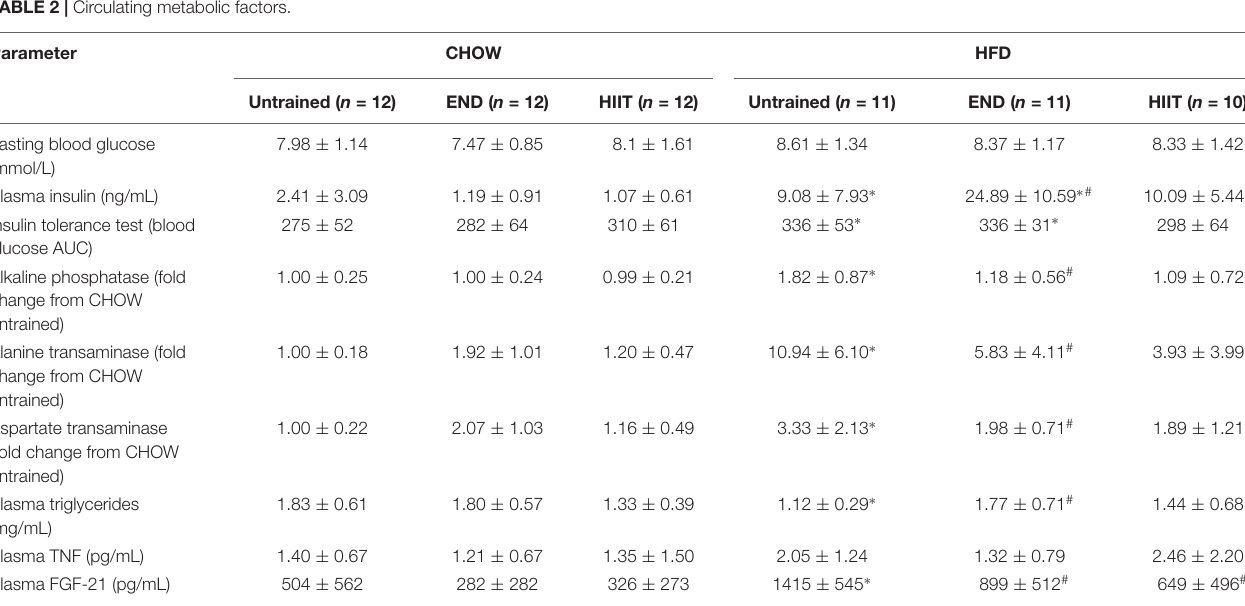
TABLE 2 | Circulating metabolic